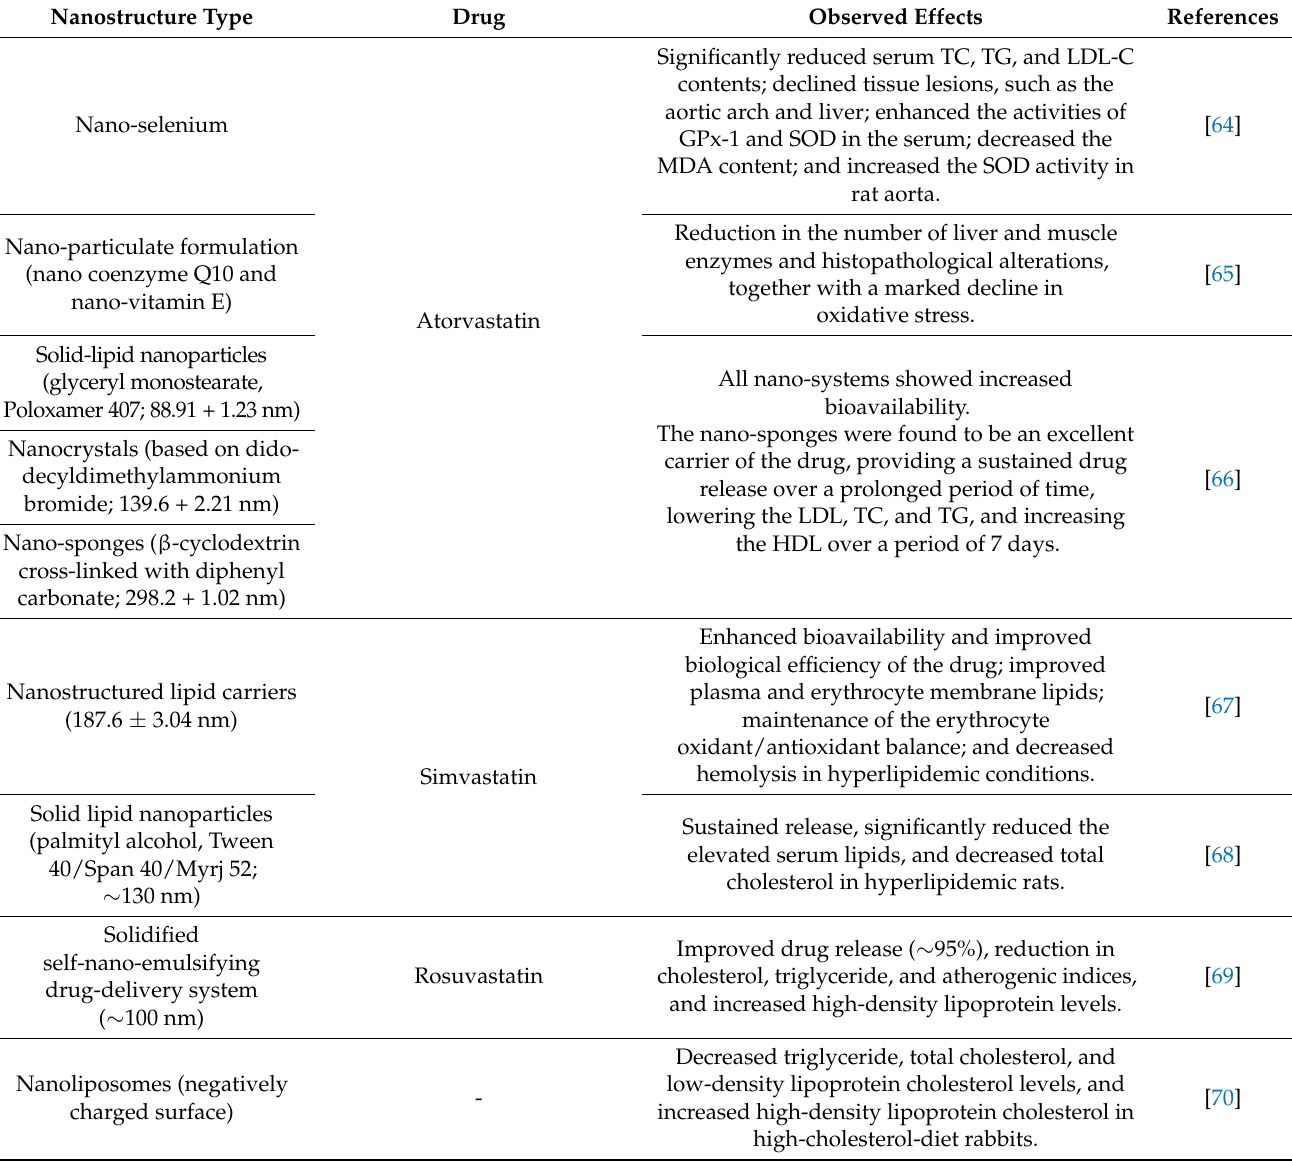
Table 4. Drug-based nanostructures and their therapeutic roles in the management of